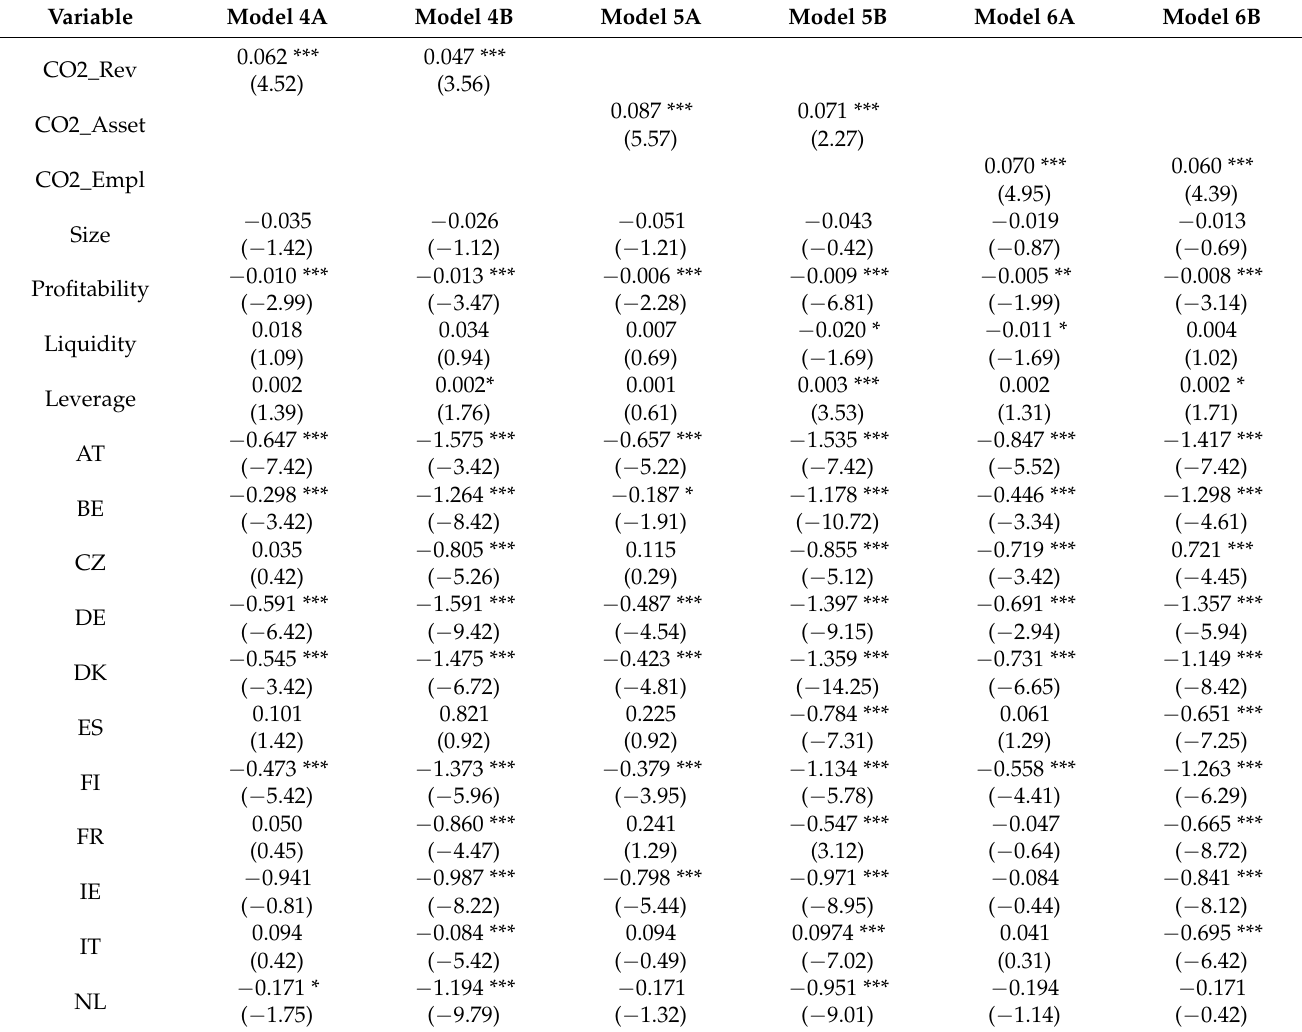
Table 5. The estimation results of regression models with country dummy